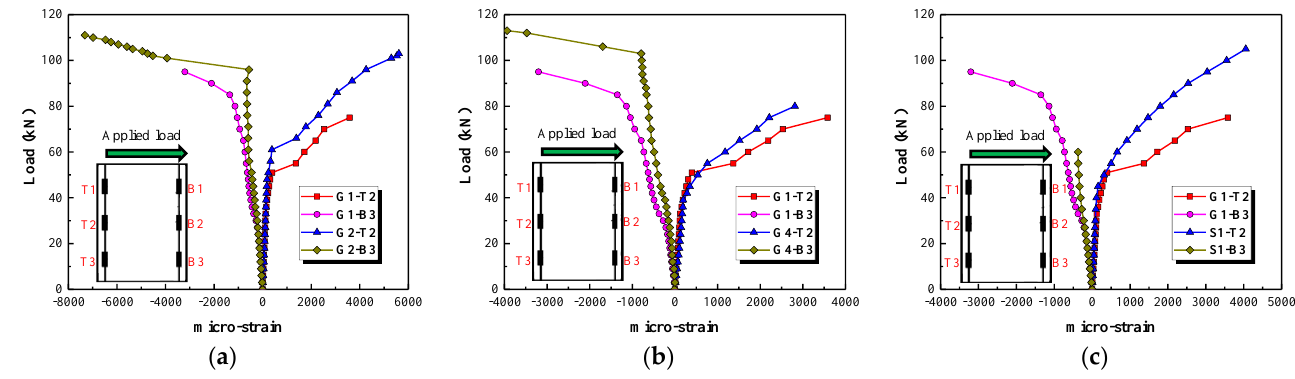
Figure 17. The effect of three parameters on the strain in the longitudinal bars. ( a ) Stirrup reinforcement ratio; ( b ) Longitudinal reinforcement ratio; ( c ) Type of stirrups.